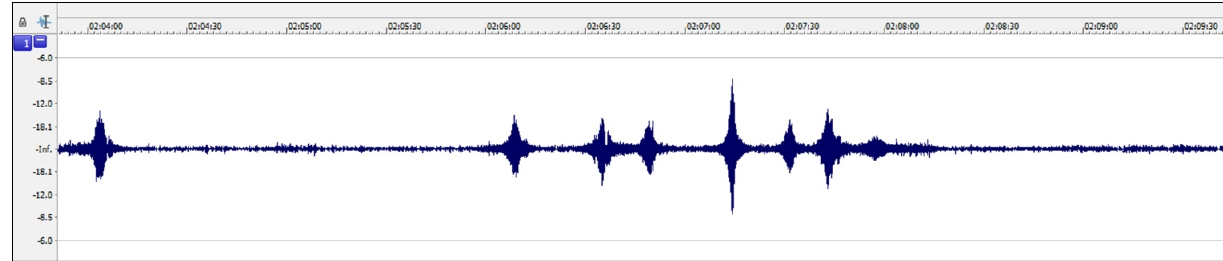
Figure 4. Soundscape map, 2:00 a.m.–3:00a.m., 23 August 2013 (53°18'10.1"N 2°58'00.9"W).